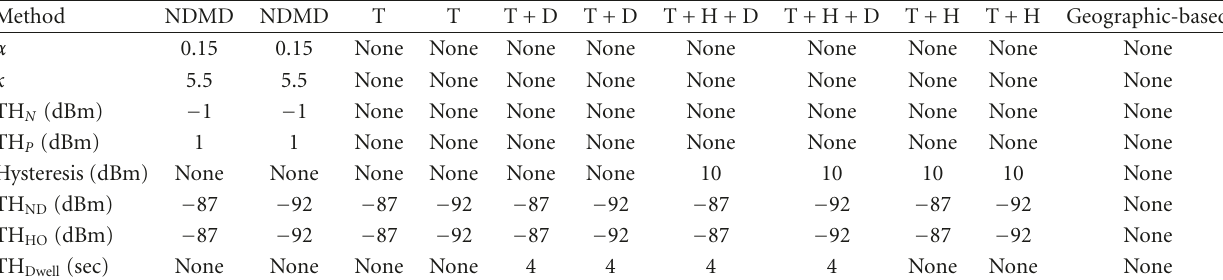
Table 7: Parameters for di ff erent hando ff mechanisms.